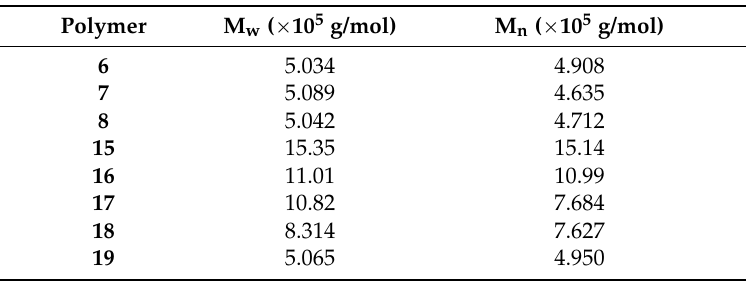
Table 2. GPC results of the polymers 6 – 8 , 15 – 19.